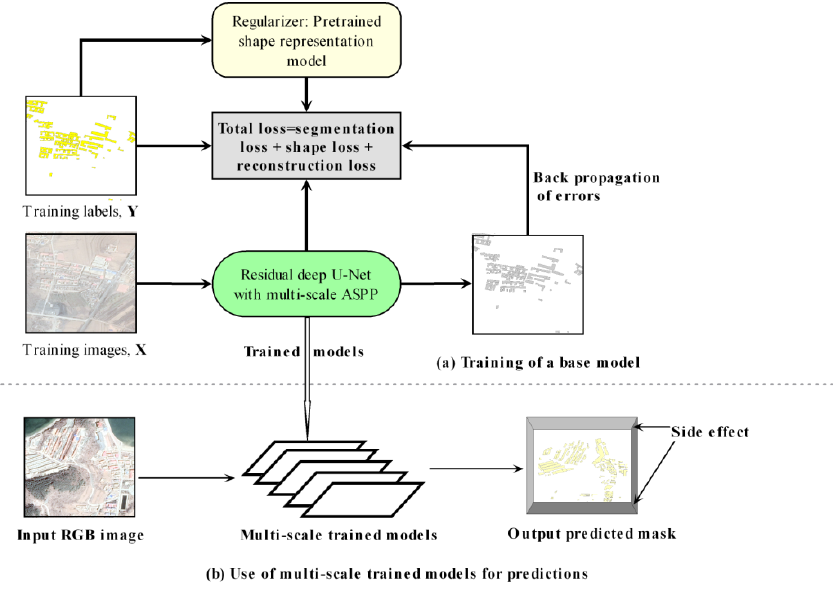
Figure 5. Training ( a ) of the base segmentation model with incorporation of shape representation regularizer and prediction ( b ) by multi-scale trained models.